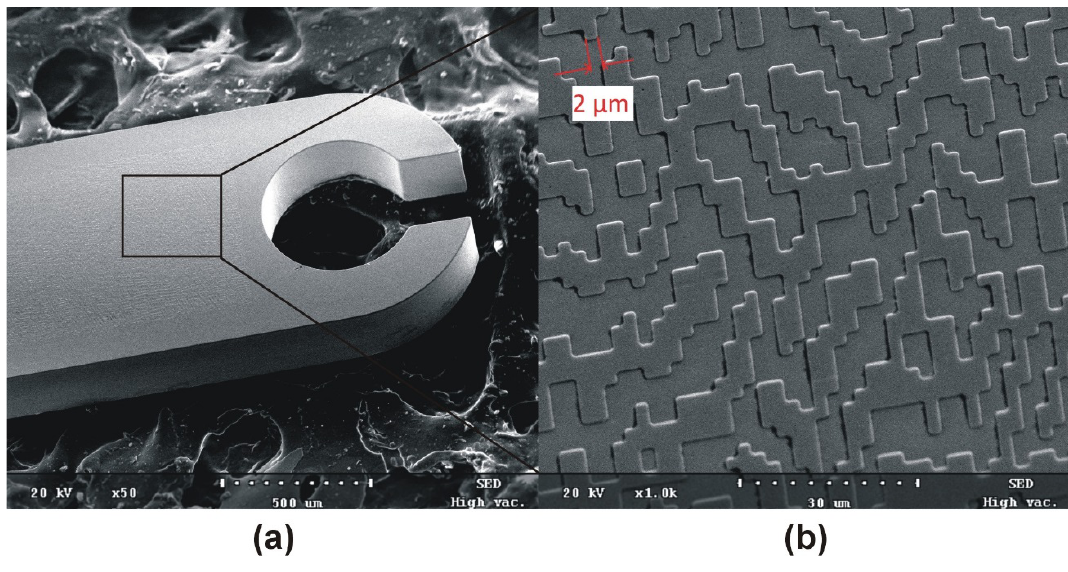
Figure 9. SEM images of a LIGA part with a nanostructured DOE: ( a ) A 200 µm-thick functional microcomponent with an etched DOE; ( b ) a close-up of the nanostructured features. Pixels are 2 µm wide and 130 nm